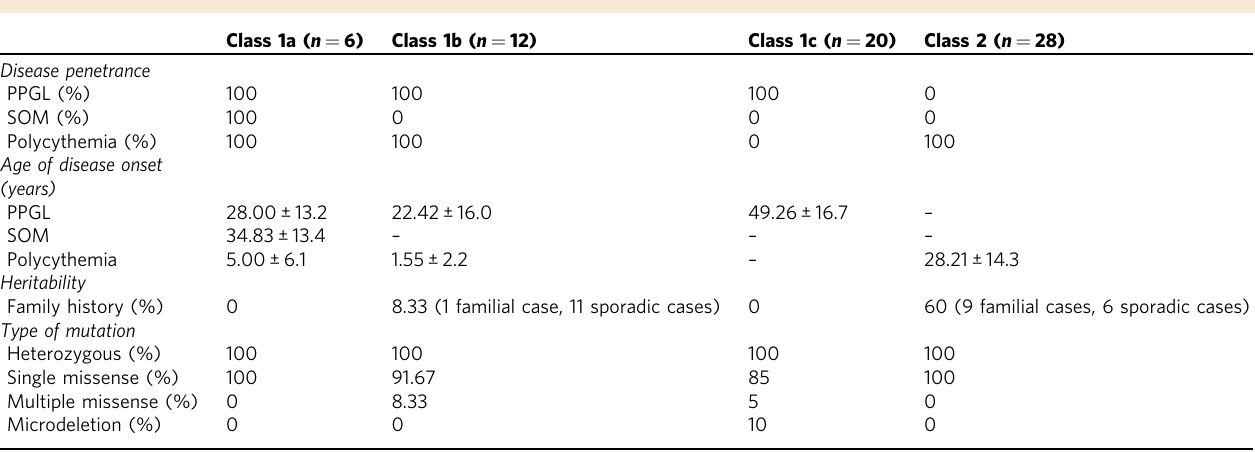
Table 1 Clinical features of HIF-2 α -driven